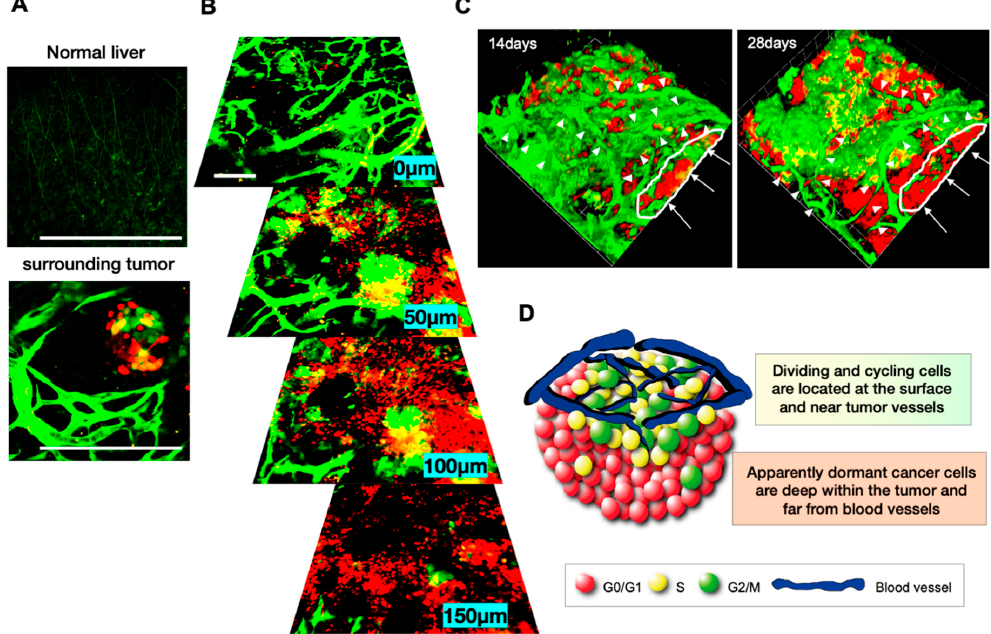
Figure 7. Intravital imaging of GFP-expressing tumor blood vessels and FUCCI-expressing cancer cells in tumors at different stages and at depths within tumors. ( A ) Representative images of tumor angiogenesis in nude mice expressing nestin-driven GFP in nascent blood vessels. Cancer cells induce tumor angiogenesis. Scale bar; 500 µ m. ( B ) Representative images of FUCCI-expressing tumors with GFP-expressing tumor vessels at the indicated depth from the surface. ( C ) Representative images of 3D reconstruction of FUCCI tumors, with visualized tumor vessels at 14 days or 28 days after implantation. Arrowheads indicate tumor vessels. Arrows show quiescent areas of the tumor. ( D ) Scheme of FUCCI cancer cells and tumor vessels [8,22].